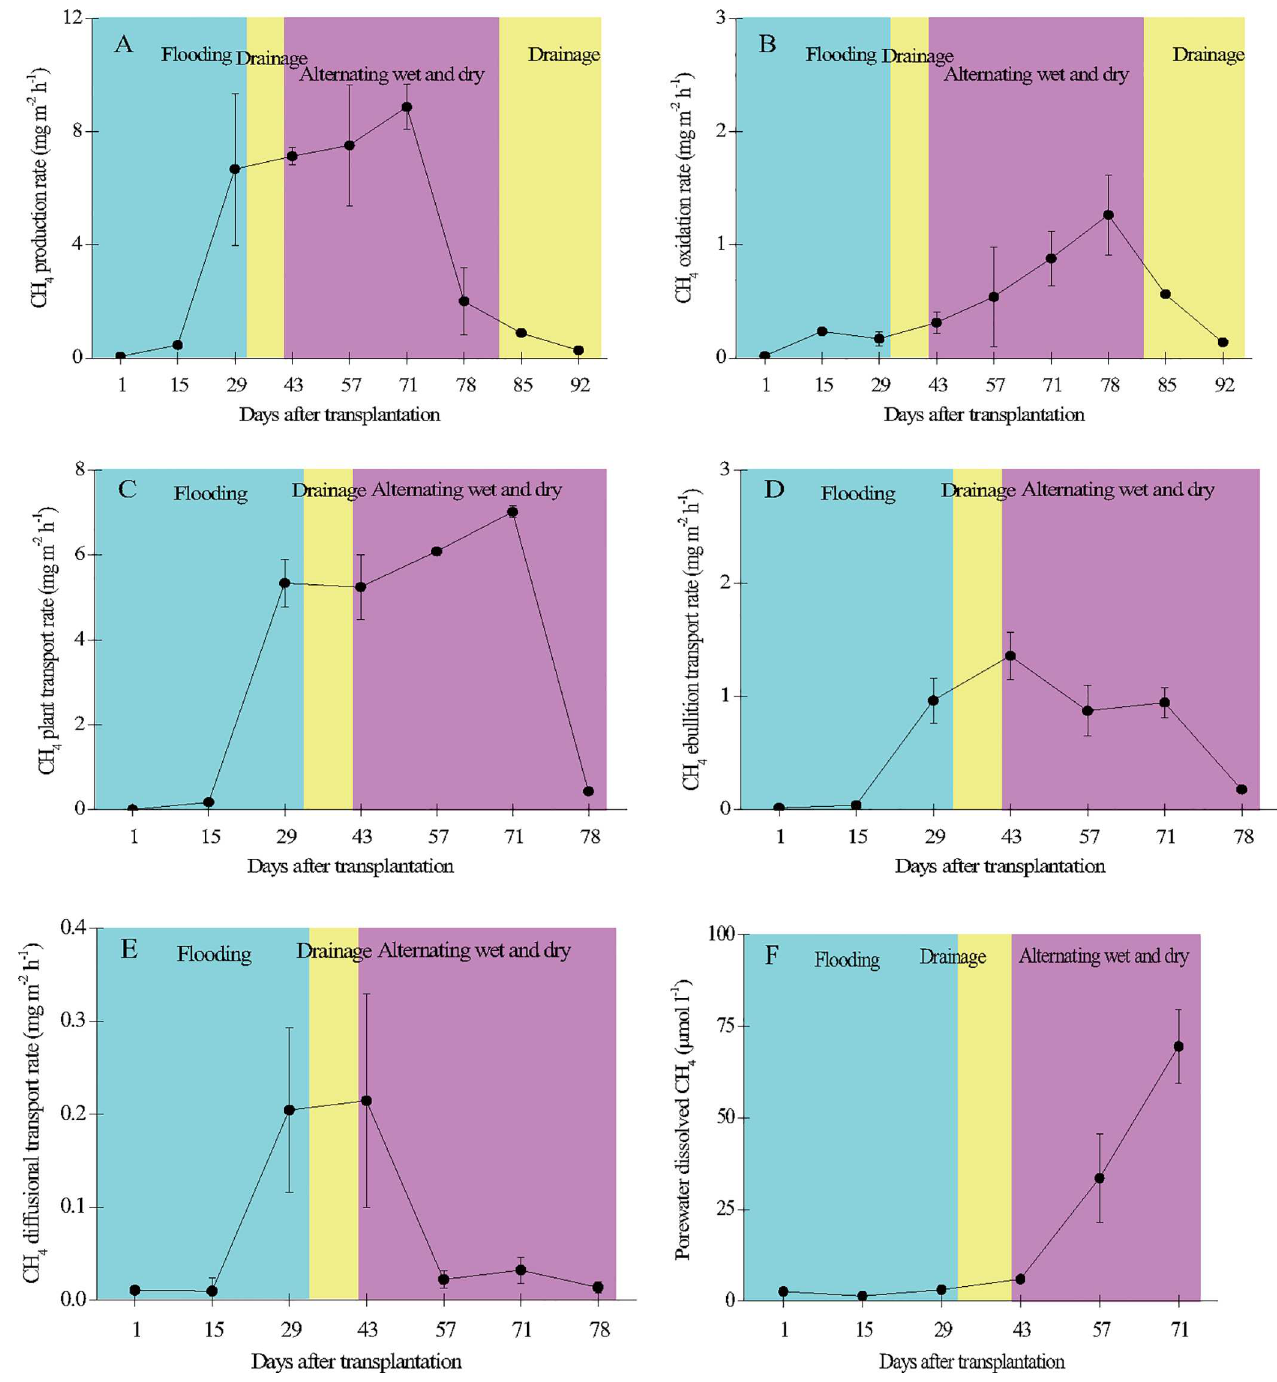
Fig 8. Seasonal variation of CH 4 production (A), oxidation (B), plant transport (C), ebullition transport (D), diffusional transport (E), and porewater dissolved CH 4 concentration (F) in the paddy field. Error bars indicate the standard error of the mean of triplicate